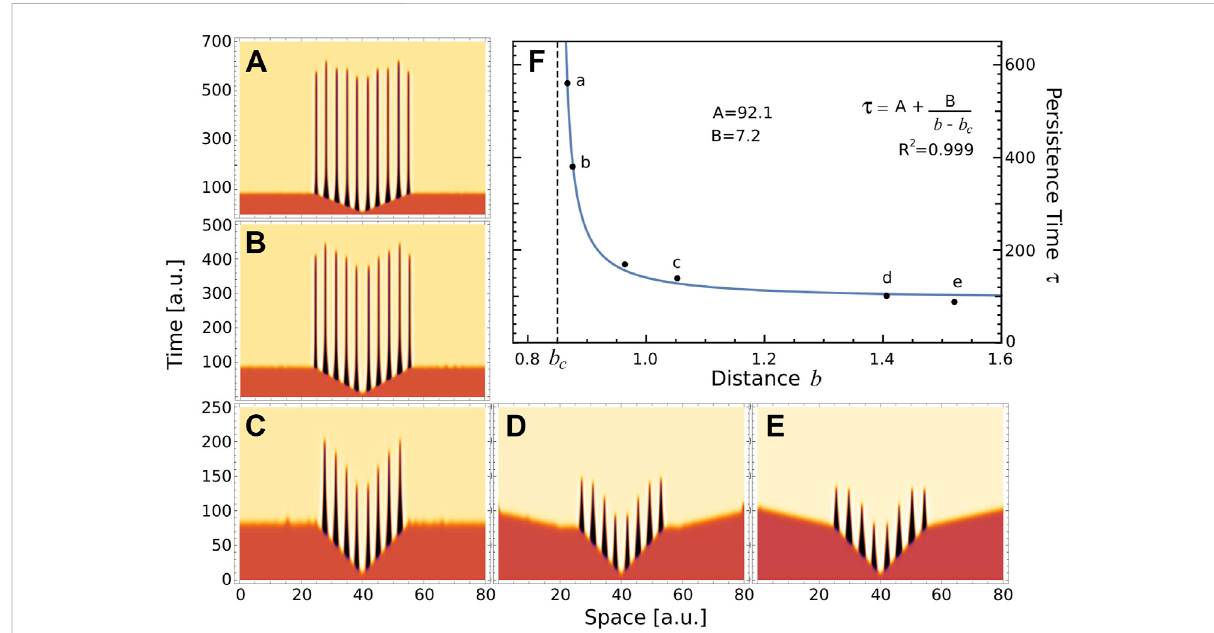
FIGURE 6 Persistence time. (A – E) These panels depict the temporal evolution of a , when the uniform distribution associated with fi xed point S 1 is perturbed at x =40, for different values of the parameters ( μ , r a , r h )=(4.89,2.5,7) (A) (4.9, 2.5,7) (B) (5.1,2.5,7) (C) (5.5,2.5,7) (D) and (5.1,2.5,6) (E) . These parameters values were indicated by crosses on 5A. (F) Raster-plot of persistence time τ and distance b for the numerical simulations (A – E) and also P 3 =(5.0,2.5,7) depicted in bottom panel of 5C. Blue line corresponds to the rational function obtained by nonlinear fi tting ( A =92.1, B =7.2 and b c =0.85). Letters a-e indicated the corresponding